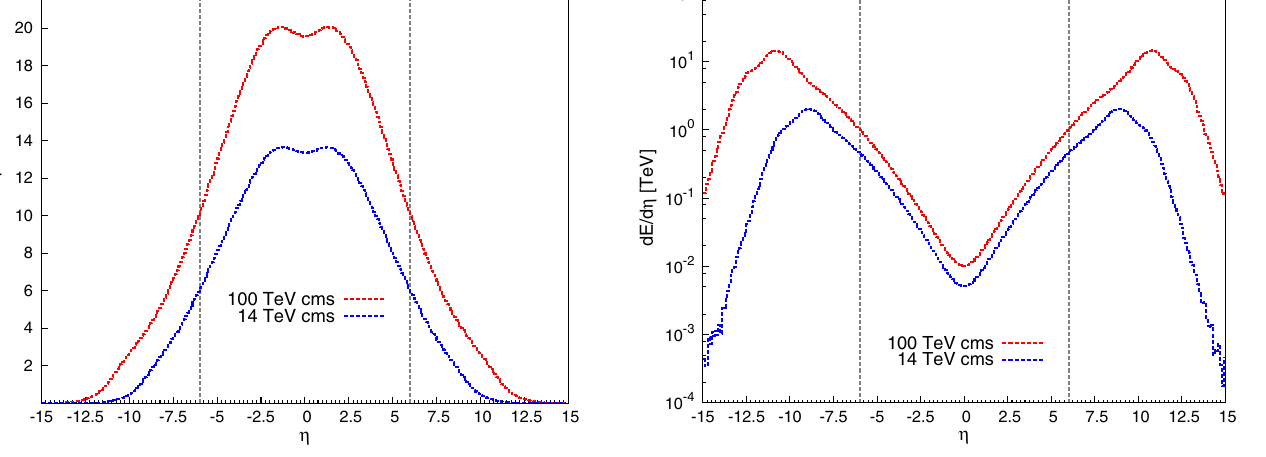
FIG. 4. Collision debris energy distribution as a function of pseudorapidity for 100 TeV p-p collisions in red and 14 TeV p-p collisions in blue at 5 mm from the nominal interaction point. The two vertical lines at η ¼ (cid:2) 6 show the detector